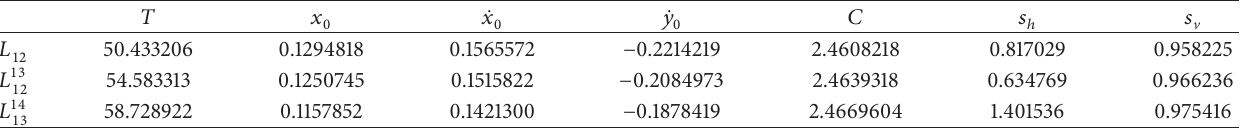
Table 2: Sample members of the long period family emanating from the triangular equilibrium point 𝐿 4 for 𝑞 1 = 0.5, 𝑞 2 = 0.8, 𝜔 = 1.5, and 𝜇 = 0.00095.